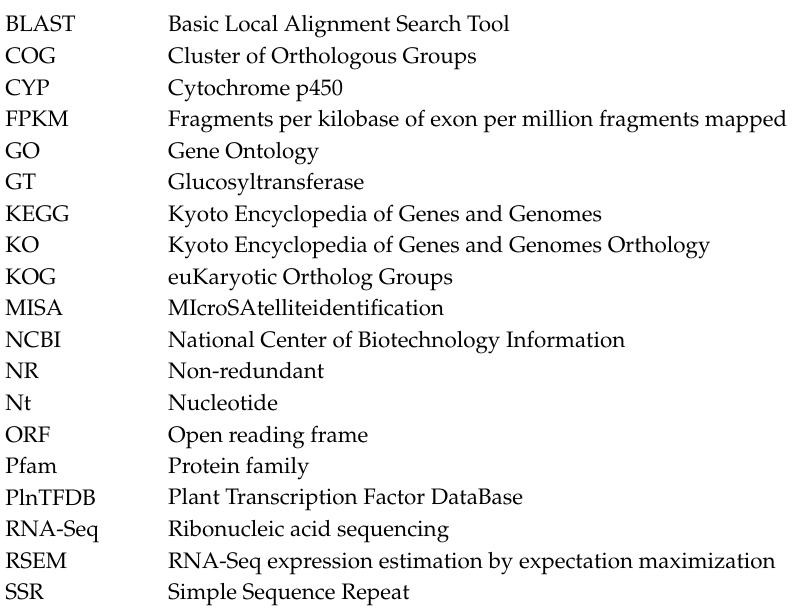
Table S1. A. marmelos detailed annotation results. Table S2. Detail list of A. maremlos transcripts annotation with Citrus sinensis genome. Table S3. Detail result of A. maremlos transcripts annotation against Citrus clementina genome. Table S4. Detailed of SSRs in the A. marmelos leaf transcriptome. Table S5. Transcriptional factors family Table S9. SSRs identified in Glycosyltransferases (GTs) transcripts. Table S10. FPKM based top KEGG IDS in A. maremlos leaf